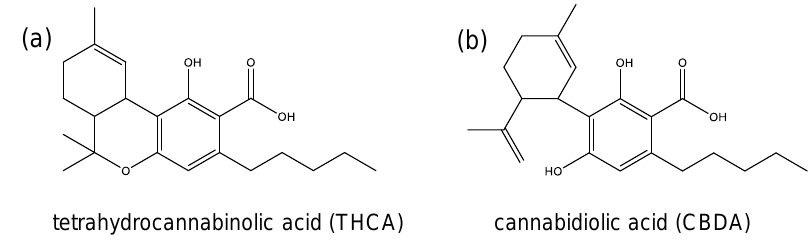
Figure 5. Chemical structures of ( a ) cannabidiolic acid (CBDA) and ( b ) ∆ 9 -tetrahydrocannabinolic acid ( ∆ 9 -THCA).